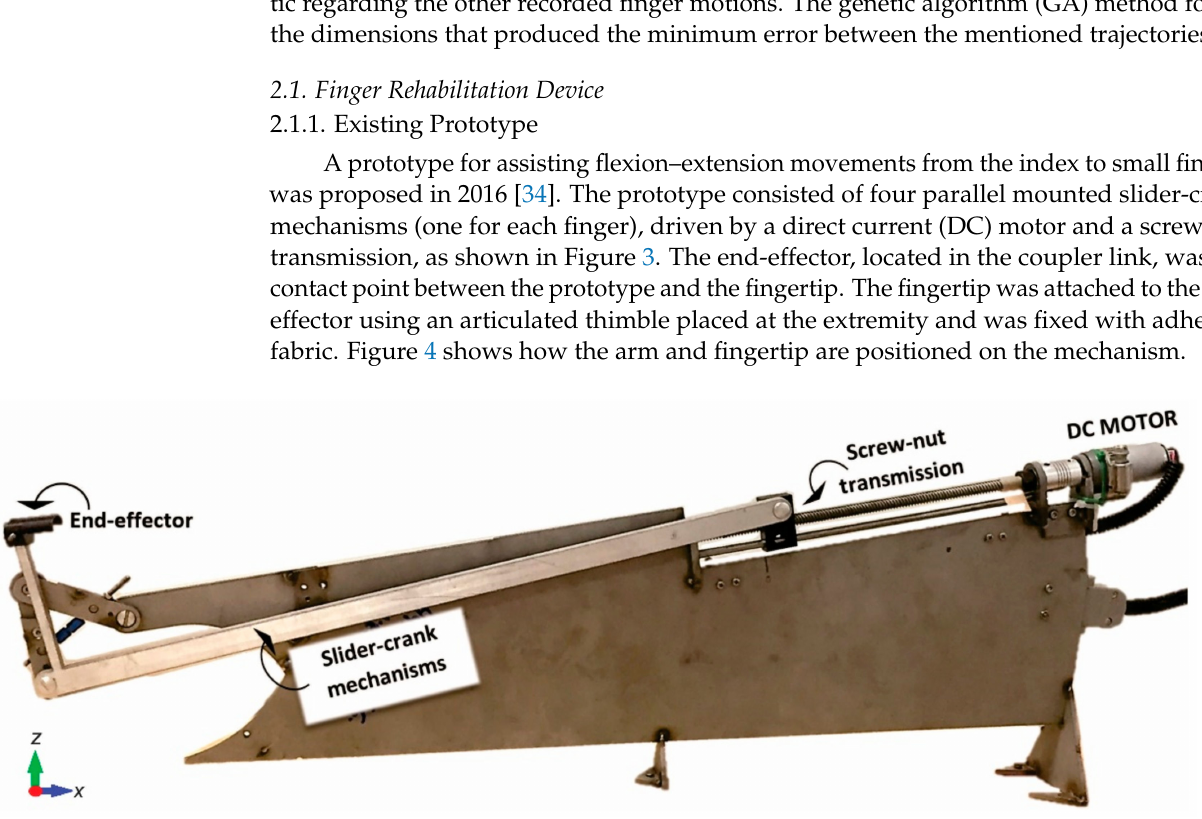
Figure 3. Finger rehabilitation prototype (back